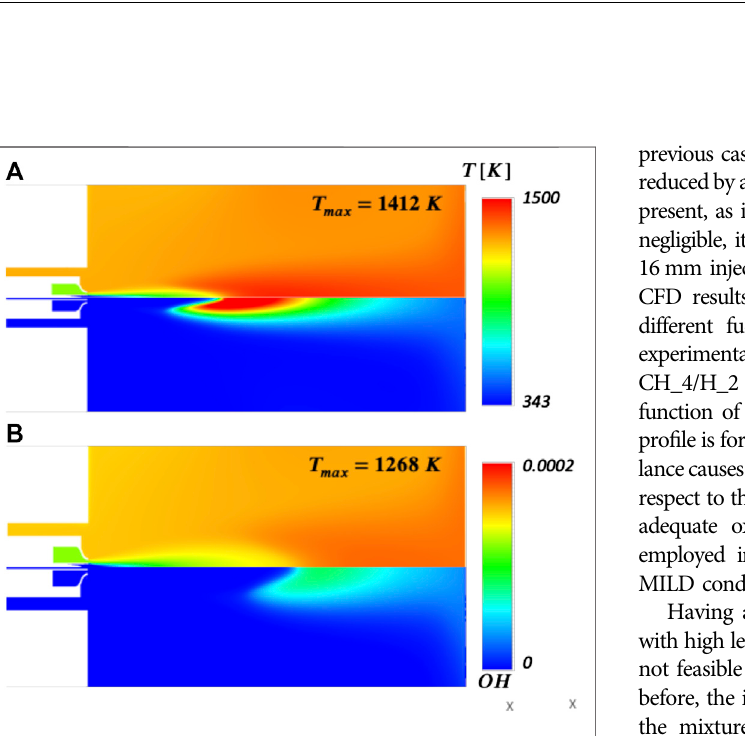
FIGURE12| Case13(a)and14(b)(70%H 2 )temperatureandOH fi elds. Figure (A) refers to dilution with 100% CO 2 in vol., fi gure (B) refers to dilution with 100% H 2 O in